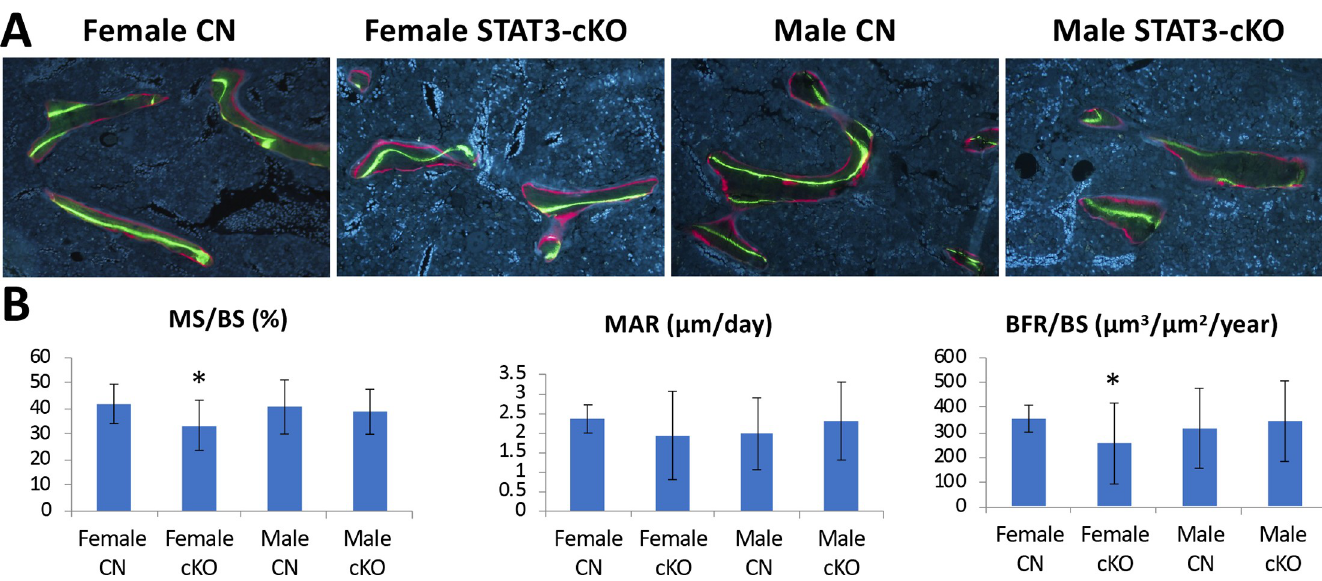
Fig 3. Dynamic histomorphometry analysis of femurs labeled with calcein and alizarin fluorescent dyes. A) Representative figures of distal femurs from 8 weeks old female and male control (CN) and STAT3-cKO mice. B) Data include mineral surface/bone surface (MS/BS), mineral apposition rate (MAR), and bone formation rate/ bone surface (BFR/BS). The region 0.5 mm proximal from the growth plate of each was analyzed ( � p < 0.05 compared to sex-matched controls, n = 11-17/group).